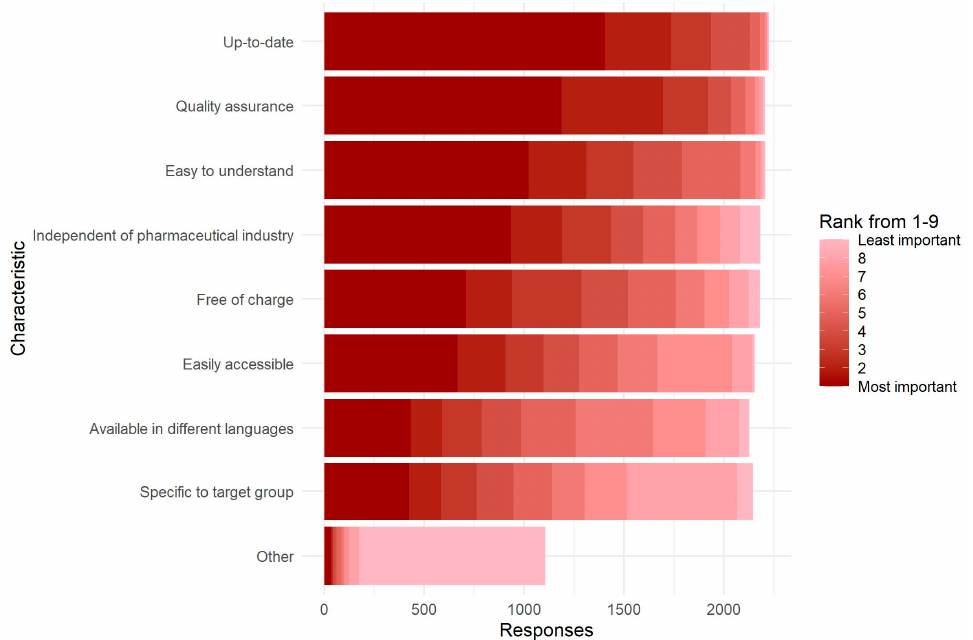
Figure 2. Characteristics of information materials about TBE vaccination and tick-borne diseases that are most important to primary care physicians (N = 2242), TBD-Prev survey, Germany, 24 May–30 September 2022. Physicians were asked to rank characteristics from 1 (most important) to 9 (least important). Of 2321 participating physicians, 79 did not answer this